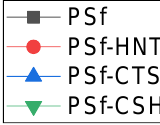
zeta potential of CTS-Si/HNT.